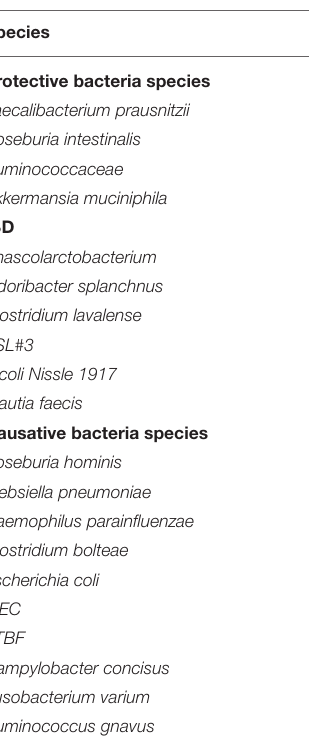
TABLE 1 | Variation and function of common probiotics and pathogenic bacteria in